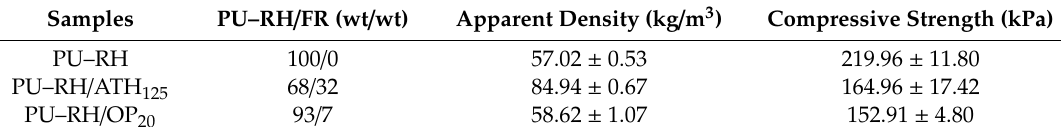
Table 5. Physical and mechanical properties of the PU–RH and PU–RH / FR mixtures.